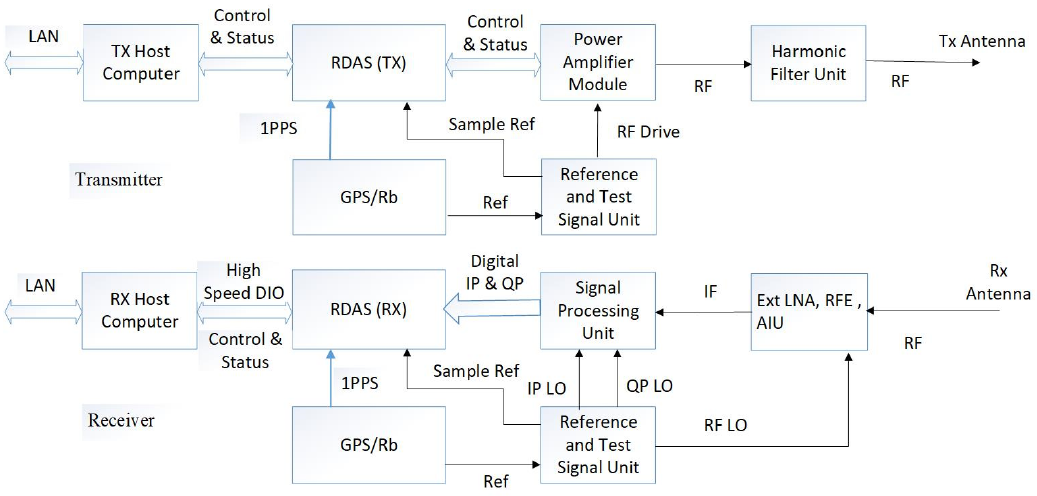
Figure 1. Block diagram of the radar system of the Chung-Li ionosonde, in which the major functional units of the radar system and the primary interconnections between the units are shown. For the details of the units, refer to the text.